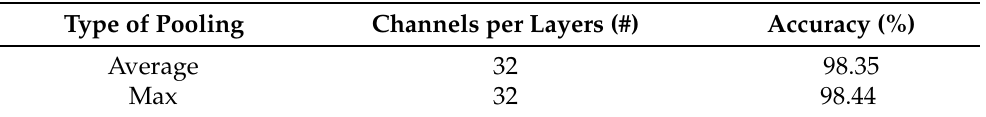
Table 2. Max pooling vs. Average